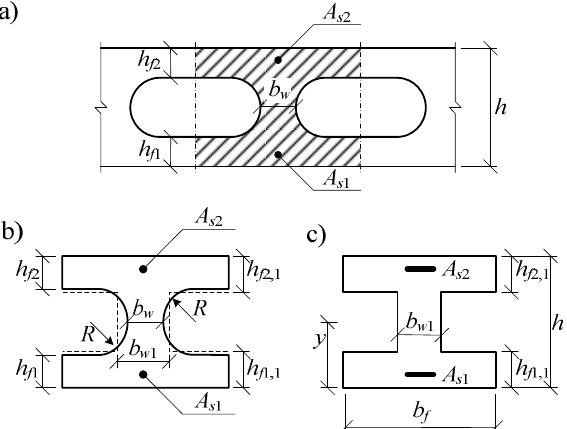
Fig. 7. The cross-section of the hollow monolithic reinforced concrete slab: a) actual; b) effective, calculating flexural capaci- ty; c) effective, calculating